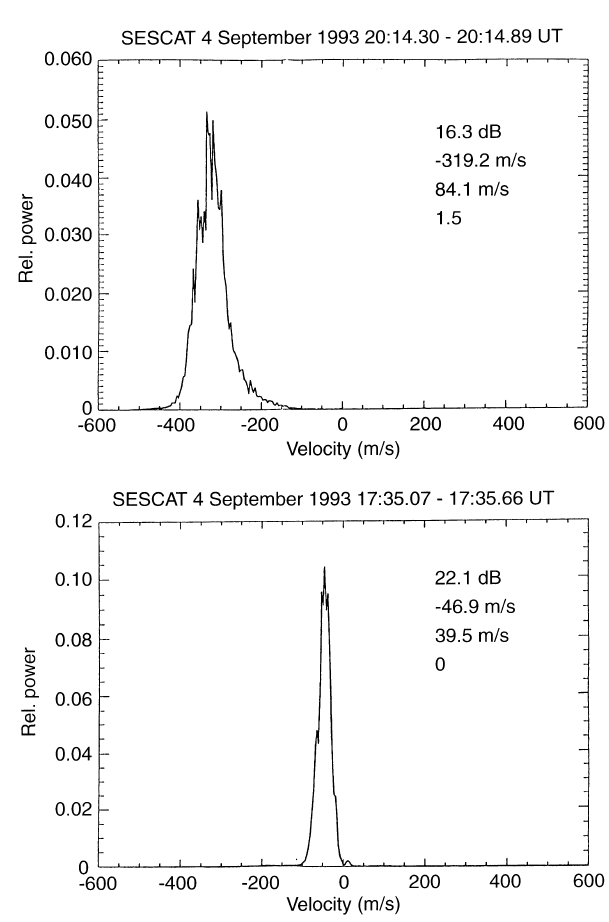
Fig. 4. Examples of SESCAT Doppler power spectra. The lower panel shows a commonly observed spectrum at small Doppler shifts. The largely shifted spectrum in the upper panel is identified with pure type-1 irregularities generated by the Farley-Buneman instability. Note that the latter spectral type is